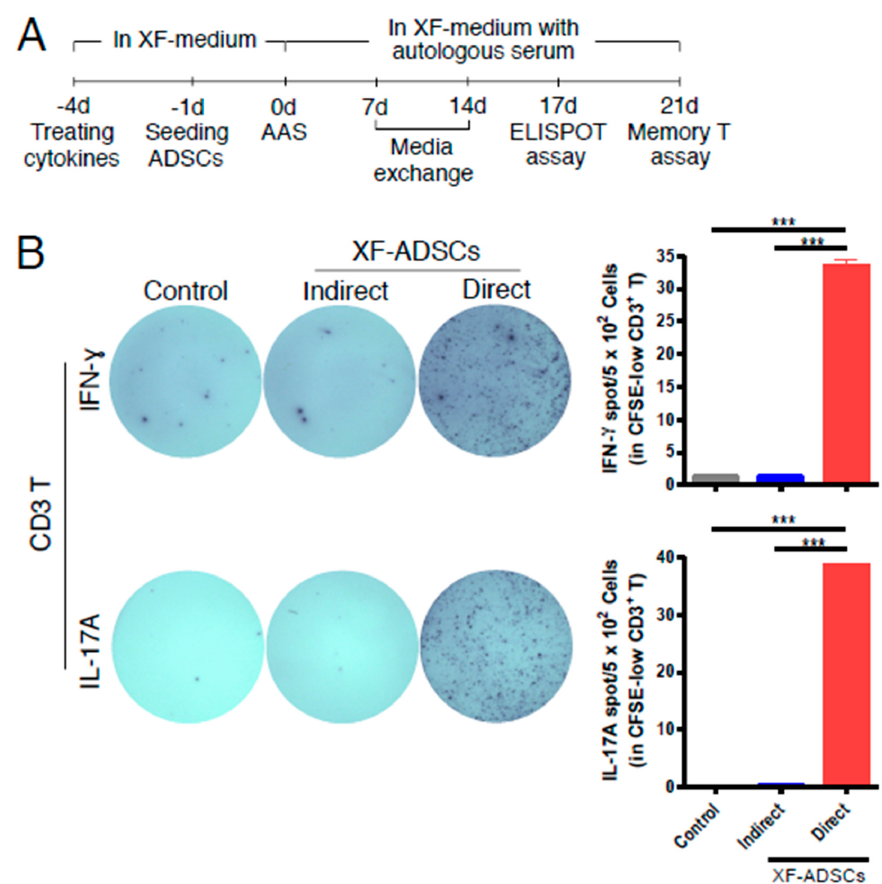
Figure 3. Analysis of antigen recognition pathways for immunogenicity evaluation of XF-ADSCs via allogeneic–antigen stimulation. ( A ) A three-week experimental scheme is depicted. ( B ) The antigen